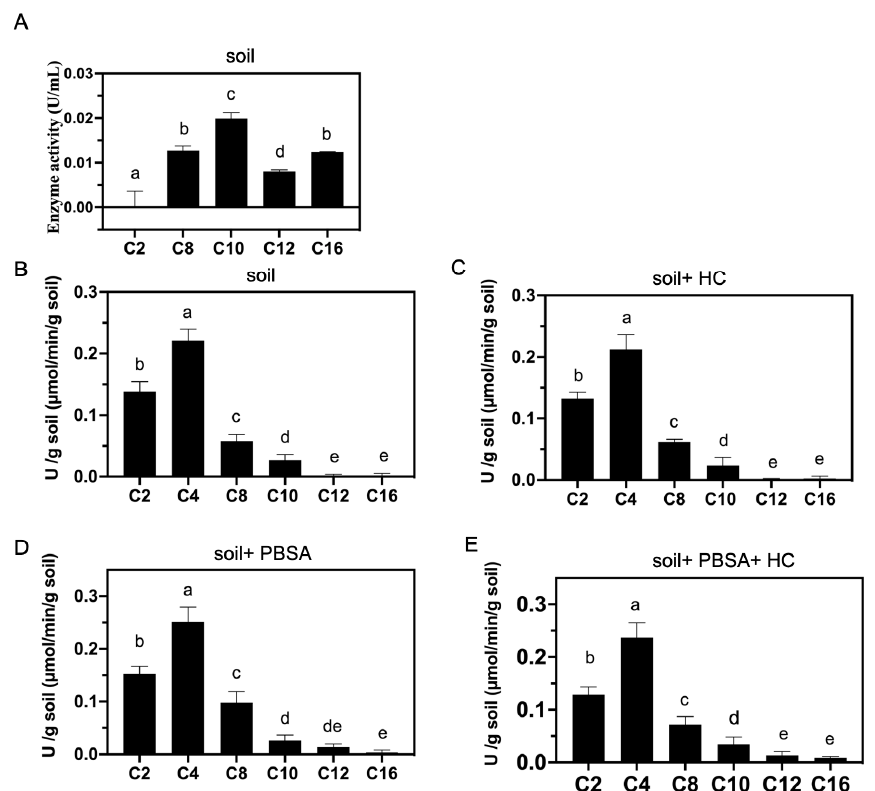
Figure 7. Lipolytic enzyme activities in the A. terreus HC culture broth and soil. ( A ) The lipolytic enzyme activities of A. terreus HC in the culture broth were determined by chromogenic nitrophenyl esters with different chain lengths as substrates (i.e., p -nitrophenyl esters). The supernatant of the A. terreus HC culture was collected from the culture fluid incubated with PBSA film and A. terreus HC for 60 days. ( B ) The lipolytic enzyme activities of soil. ( C ) The lipolytic enzyme activities of soil supply with A. terreus HC. ( D ) The lipolytic enzyme activities of soil buried with PBSA. ( E ) The lipolytic enzyme activities of PBSA buried soil supply with A. terreus HC. The assay was conducted after 30 days of PBSA degradation in soil. The substrates used were as follows: C2, 4-nitrophenyl acetate; C4, 4-nitrophenyl butyrate; C8, 4-nitrophenyl caprylate; C10, 4-nitrophenyl decanoate; C12, 4-nitrophenyl dodecanoate; and C16, 4-nitrophenyl palmitate. The results are presented as the mean ± standard deviation ( p < 0.05; Tukey’s post hoc ANOVA test).